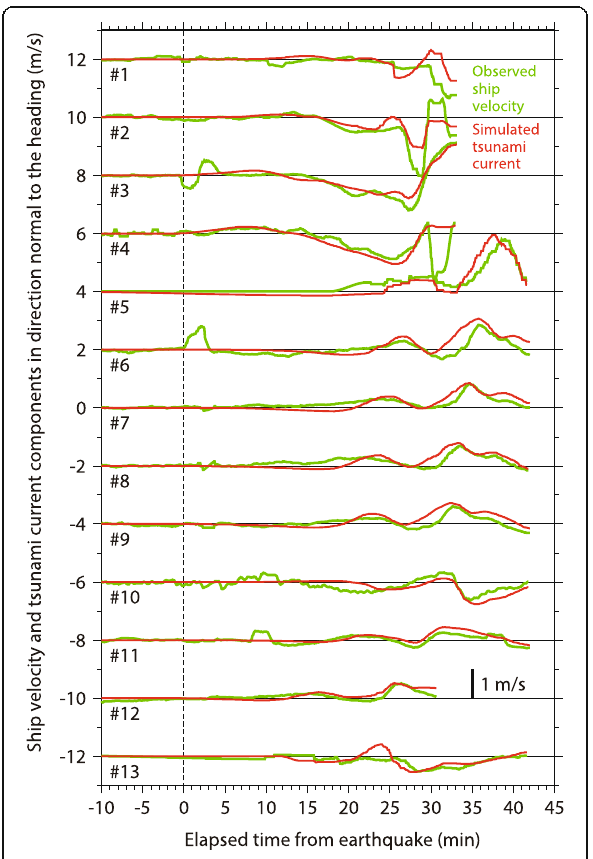
Fig. 5 Observed ship velocity (green) and simulated tsunami current (red) components in the HDG-normal direction. The ship velocity component is calculated from Eq. (1)